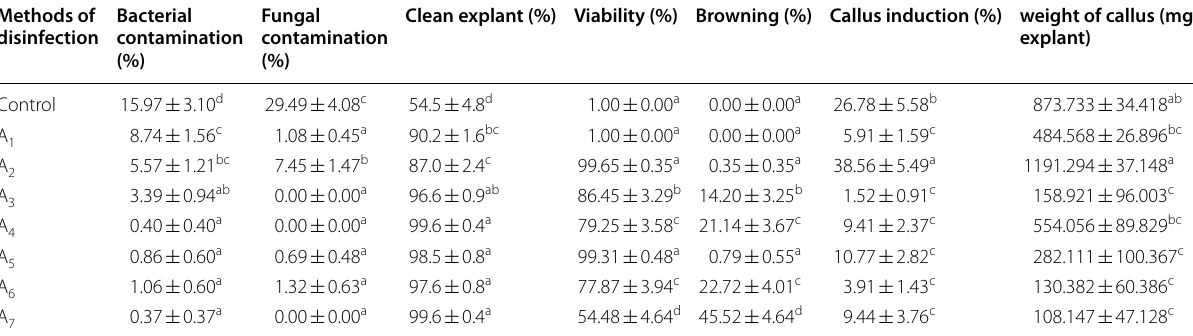
In each column, different letters indicate a significant difference ( P